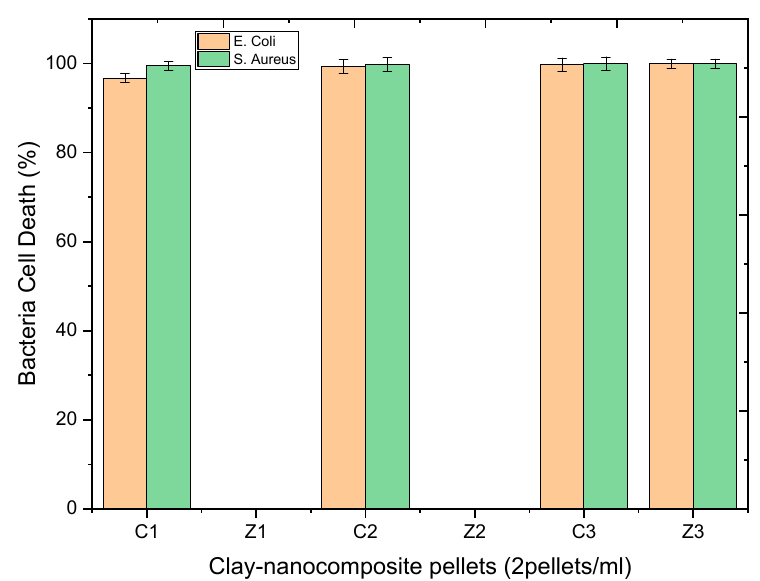
Figure 24. Histogram of the antibacteria activity of clay–nanocomposites pellets against E. coli and S. aureus in sterile aqueous media after 24 h of incubation. C1, C2, C3, Z1, Z2 and Z3 respectively relates to: clay / CuO / Ag-1, clay / CuO / Ag-2, clay / CuO / Ag-3, clay / ZnO / Ag-1, clay / ZnO / Ag-2 and clay / ZnO / Ag-3. (Z1 and Z2 are empty because there was no any recorded inhibition of the bacterial species in the aqueous media).